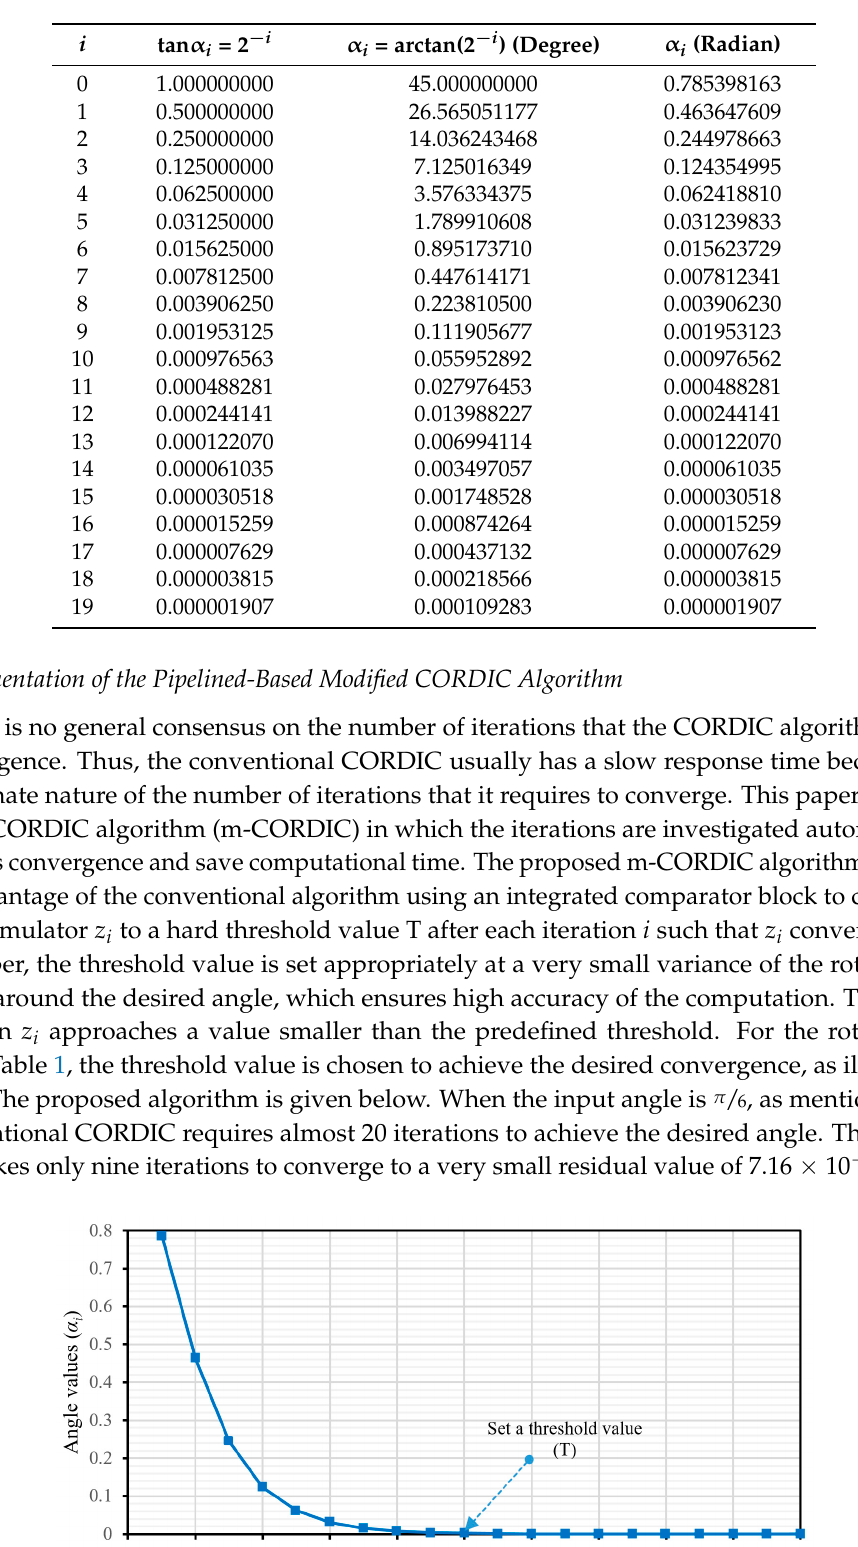
Table 1. The pre-computed α i angle values set for rotation.